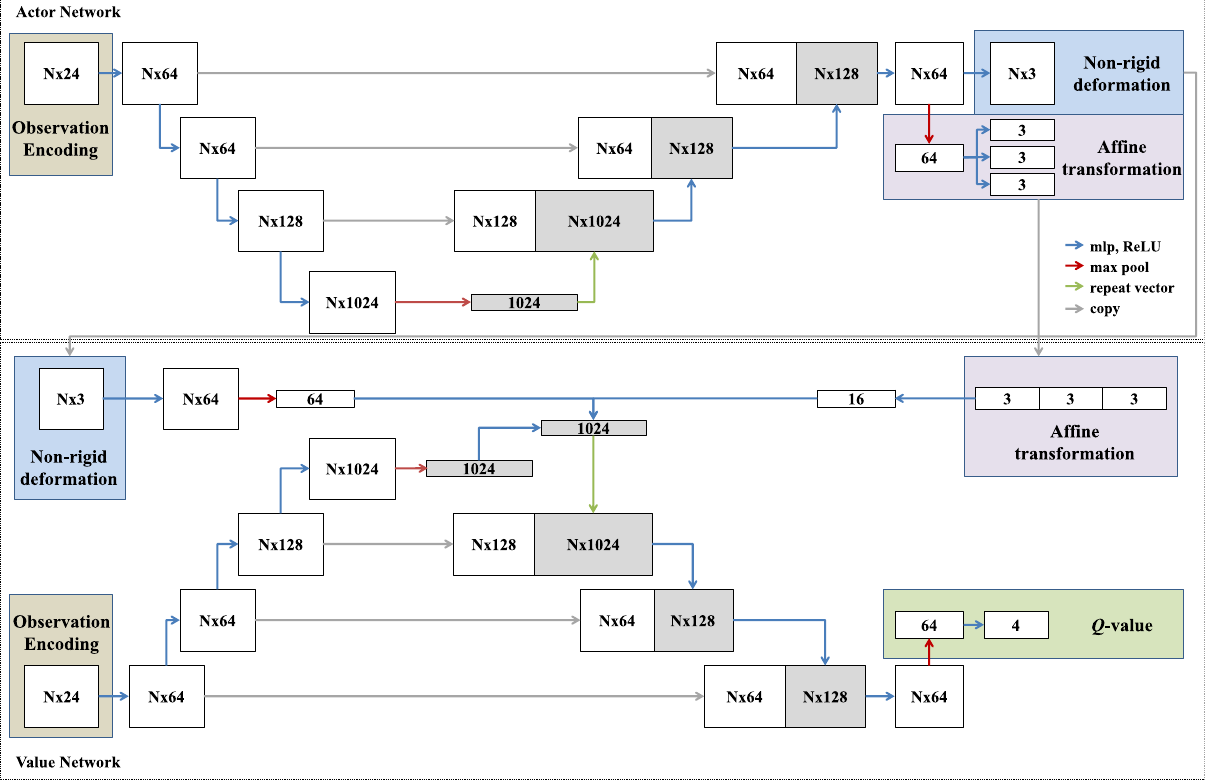
Figure 2. Illustration of the network architecture for the actor network (top) and value network (bottom), respectively. Feature maps are represented as boxes. The scalar N denotes the number of vertices. The dimension of the observation encoding block depends on the number of sampling points and on the presence of the normal